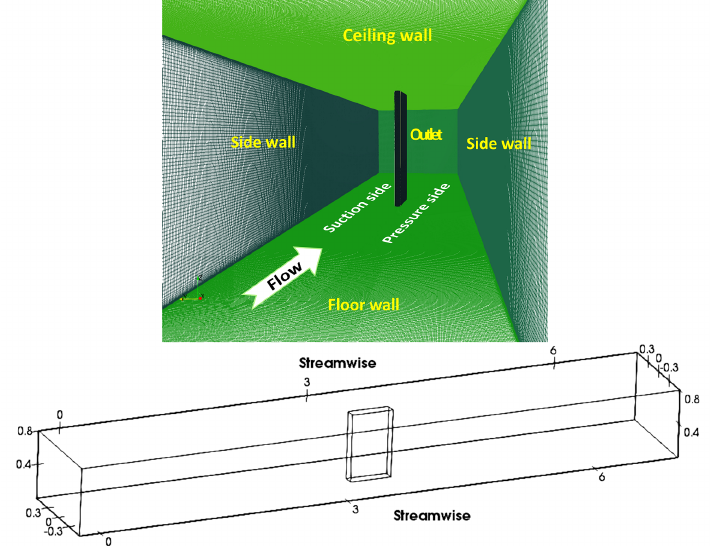
Figure 1. Illustration of the wind tunnel test section, where the flow is in positive x